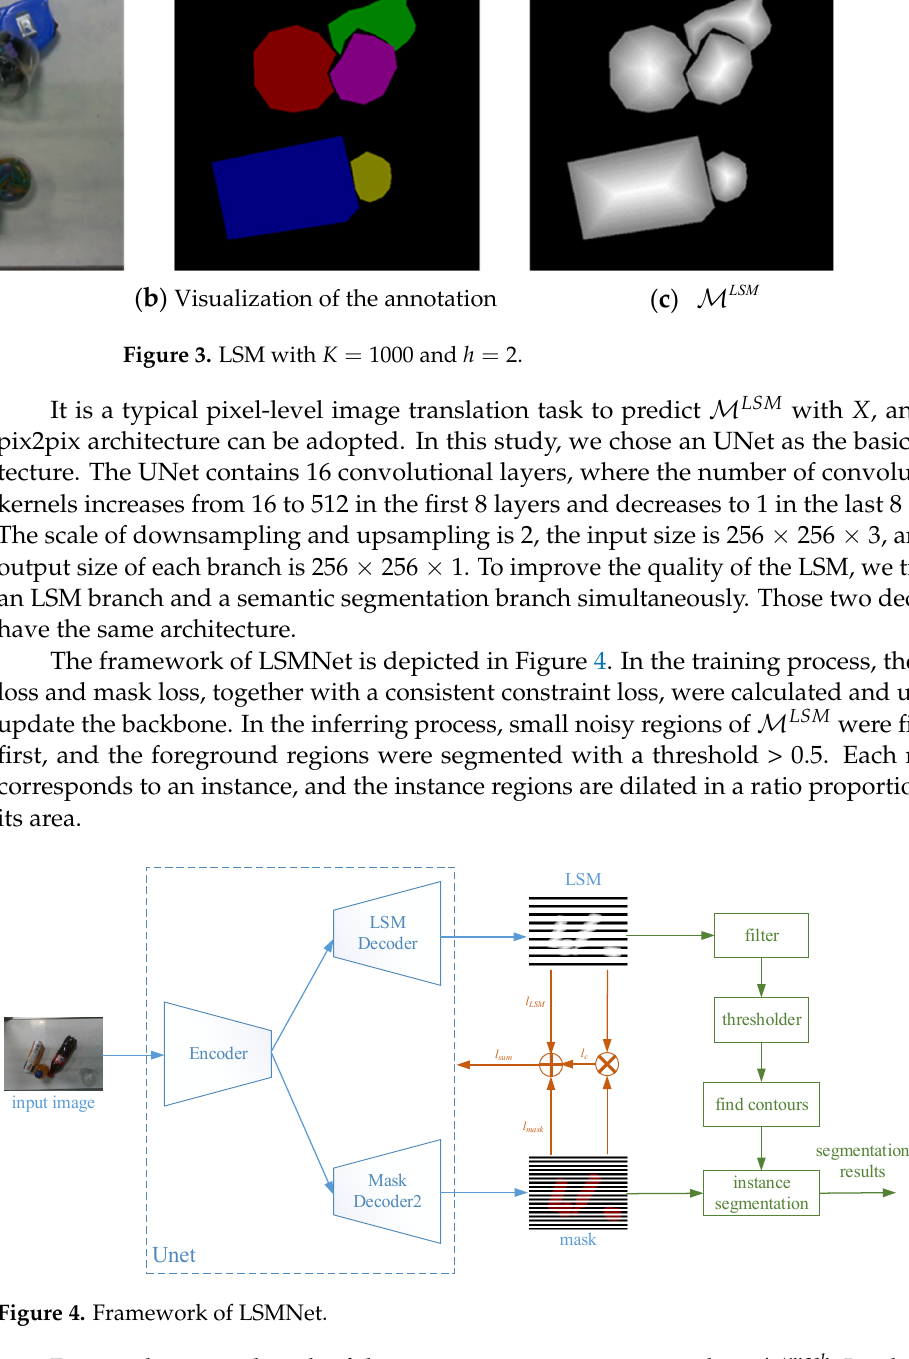
mask  . Its elements